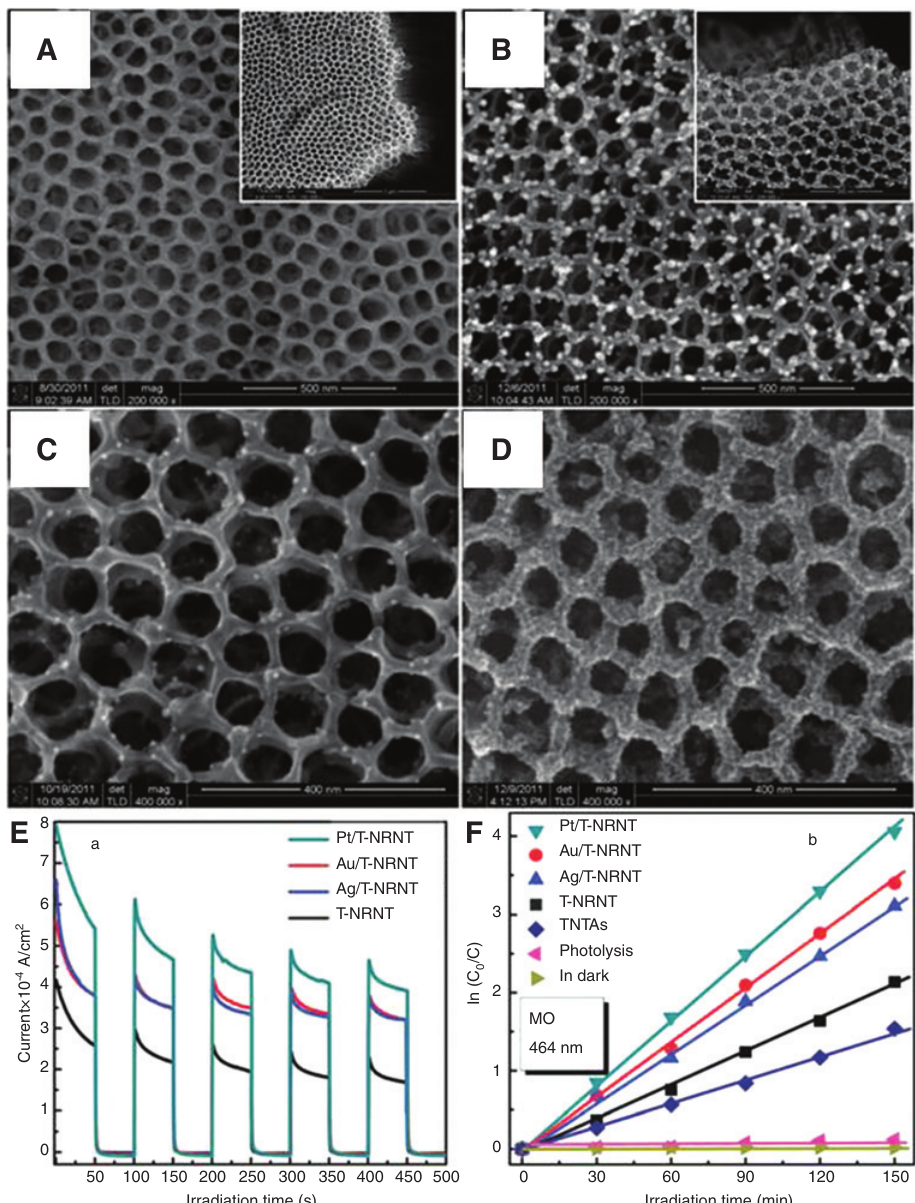
NTAs by two-step electrochemical anodization (A), Au/TiO Figure 19: SEM images of TiO 2 Photocurrent of TiO NTAs and TiO NTAs decorated with Au, Ag, Pt (E). Photocatalytic degradation rate of MO under UV irradiation (F). 2 2 Reproduced from Ref. [221] with permission. Copyright American Ceramic